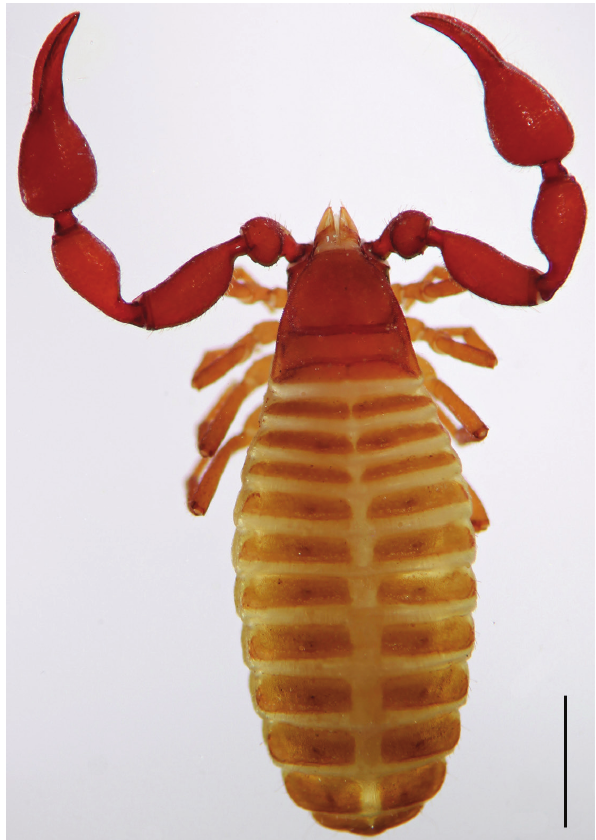
Figure 3. Female of Lasiochernes cretonatus . Scale line: 1